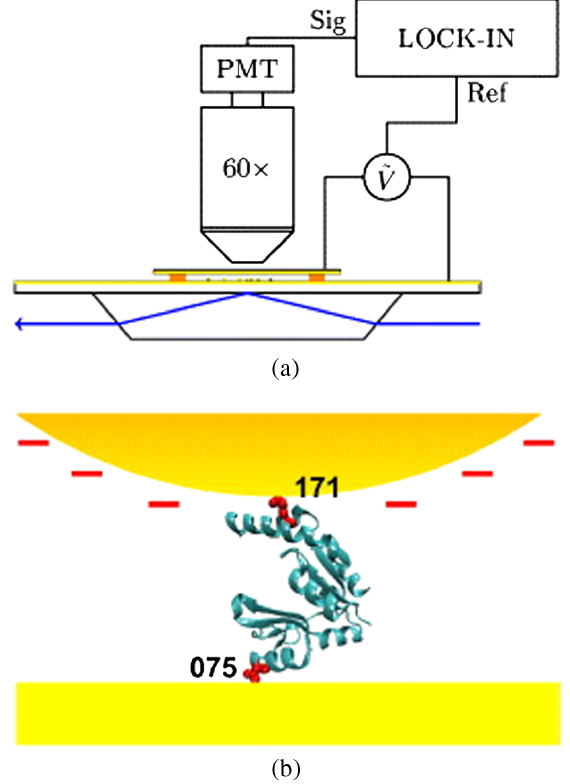
FIG. 1. The experimental system with which the data of Fig. 2 were obtained. (a) The schematics of the sample chamber with AC electrophoretic excitation and synchronous evanescent- wave-scattering optical measurement of displacement. ‘‘Sig’’ stands for signal, ‘‘PMT’’ for photomultiplier, and ‘‘Ref’’ for reference. (b) Geometry of the enzyme GK tethering a GNP to the gold-coated slide. The attachment points (residues mutated to cysteins at positions 171 and 75) are shown on the structure. The enzyme and the 20-nm-diameter GNP are drawn approximately to